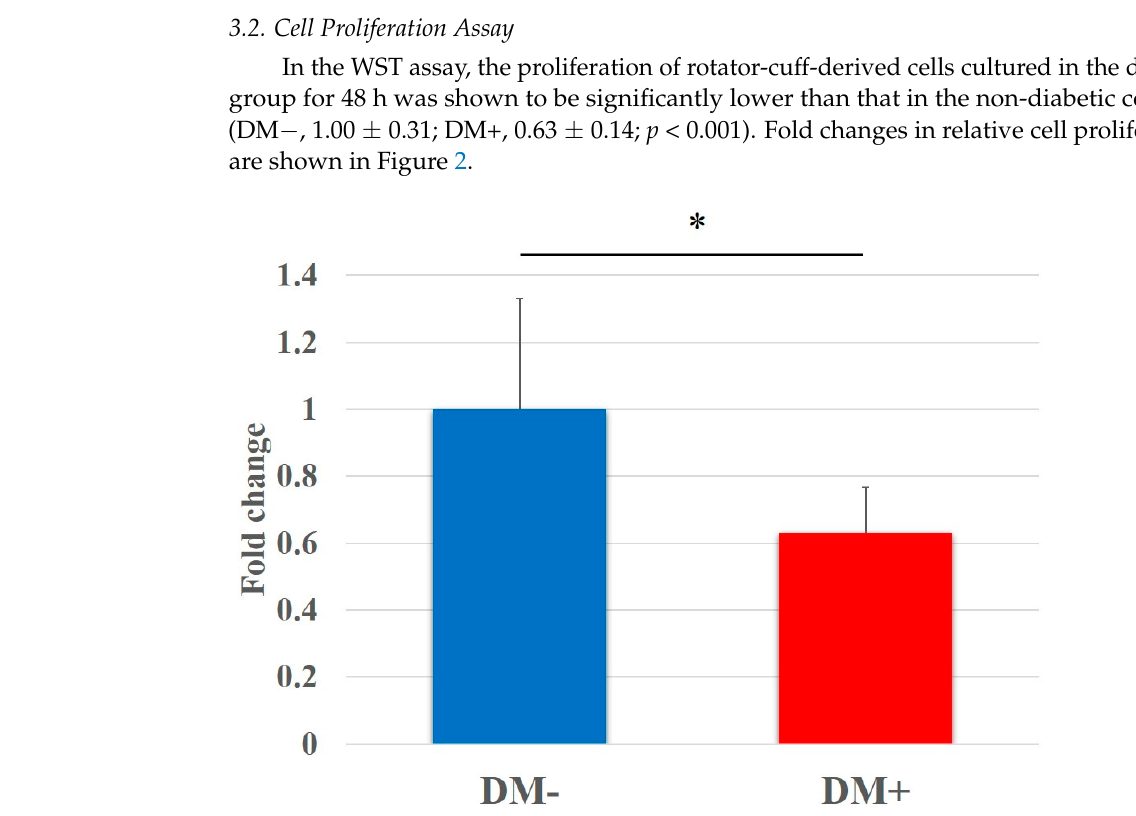
Figure 2. Proliferation of rotator-cuff-derived cells assessed using a water-soluble tetrazolium salt (WST)-based assay. Data are presented as the mean ± SD. The independent t -test was performed for determining significant differences: * p < 0.001. DM − , non-diabetic controls; DM+, diabetic group.